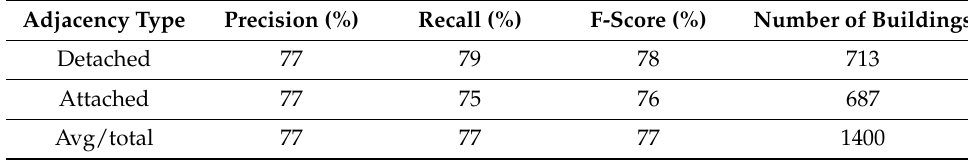
Table 2. Test results of the prediction scores at stage